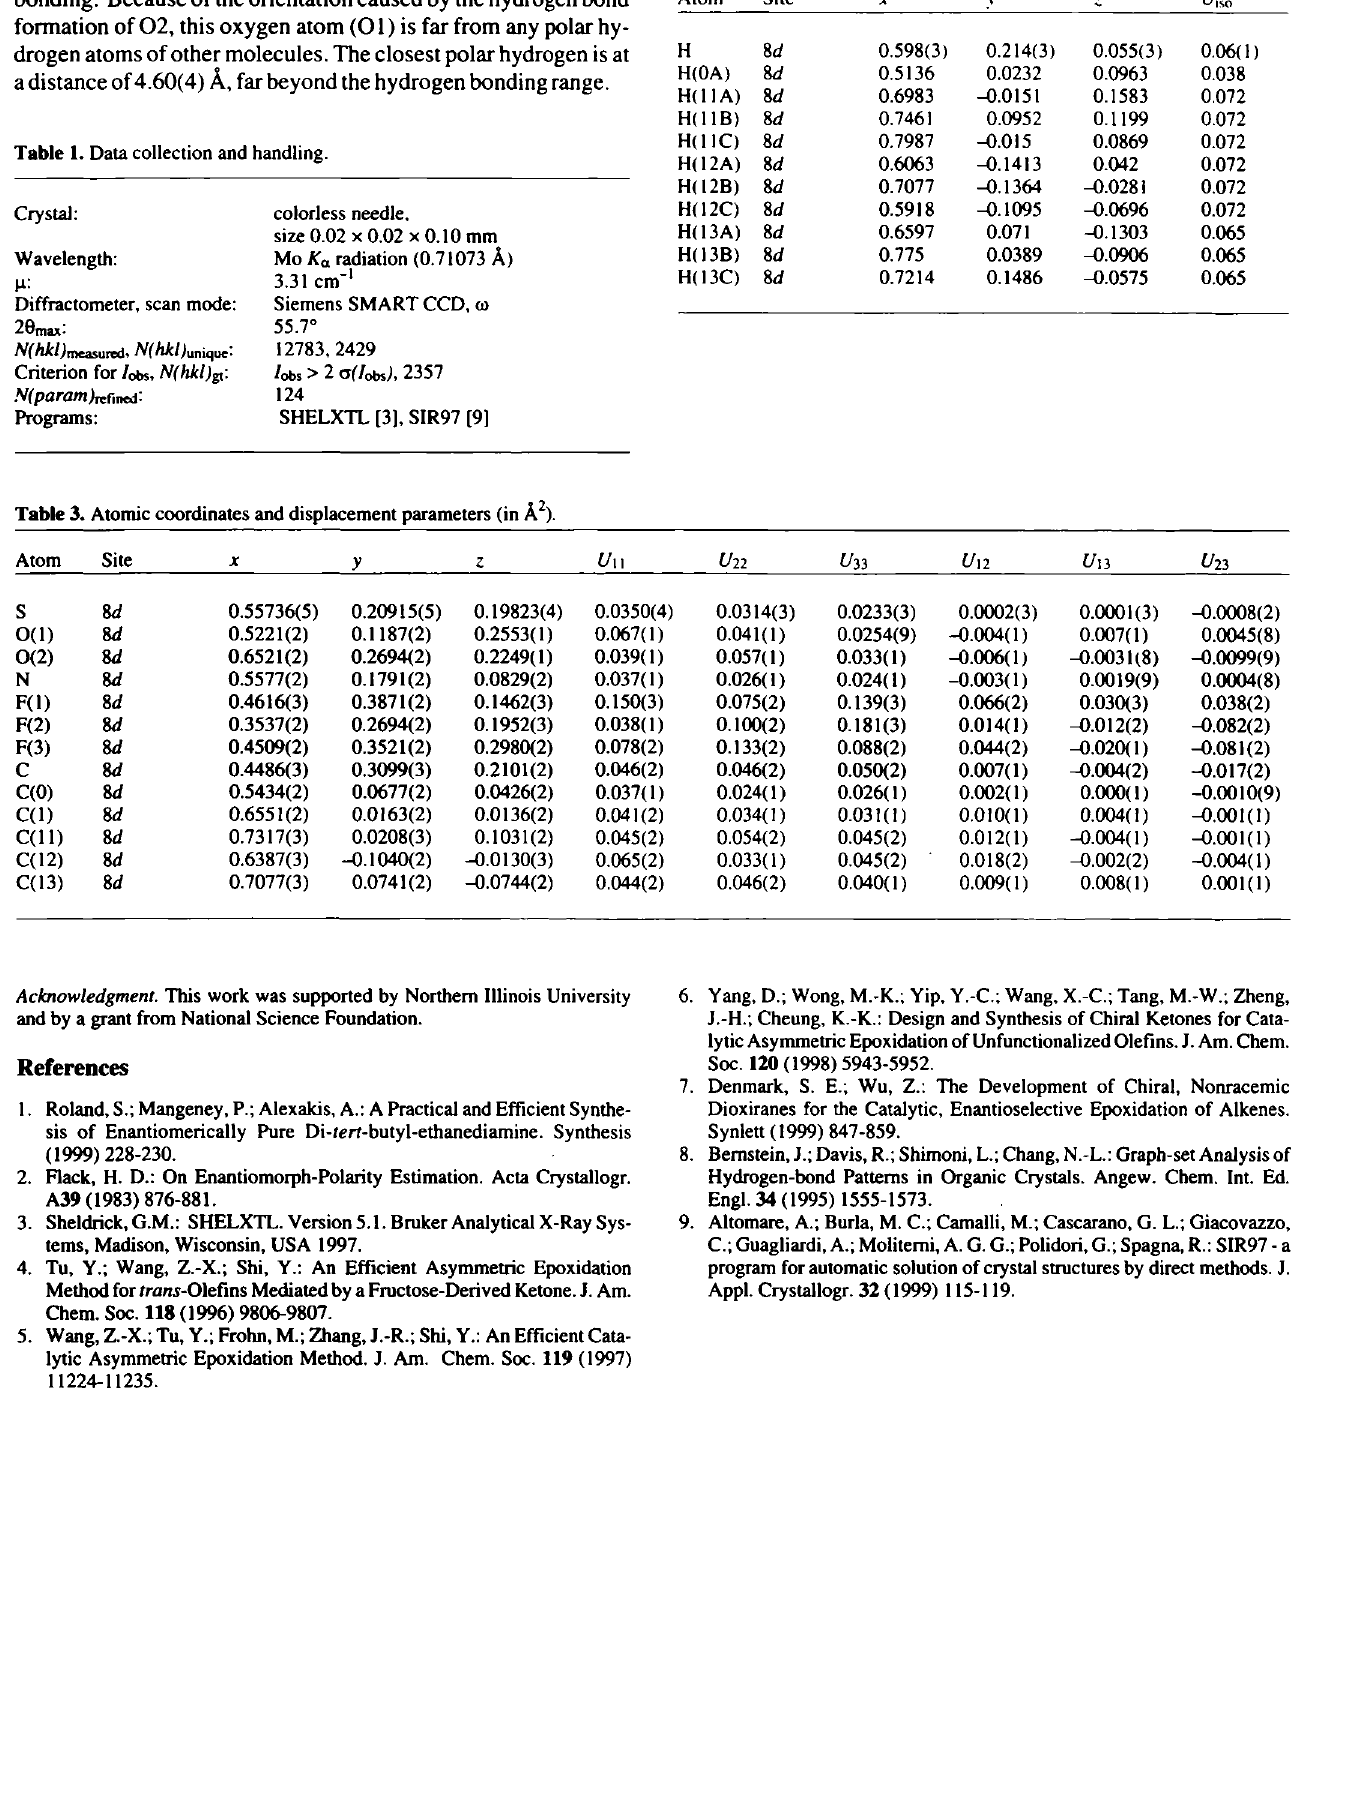
Table 1. Data collection and handling.